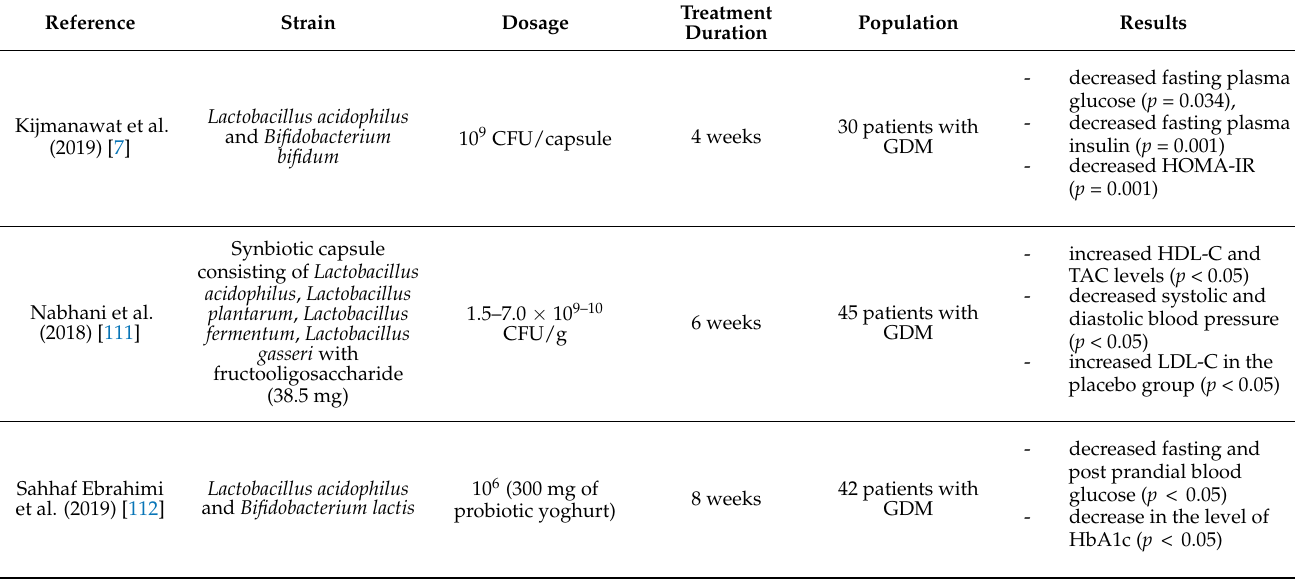
Table 2. The use of probiotics in the prevention of metabolic disorders in pregnant